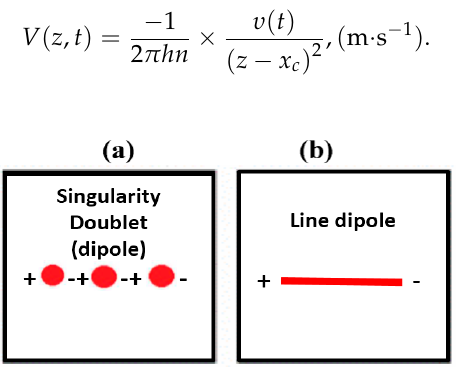
Figure 8. ( a ) Array of singularity dipoles, and ( b ) line dipole (adapted from Weijermars and Van Harmelen [79]).